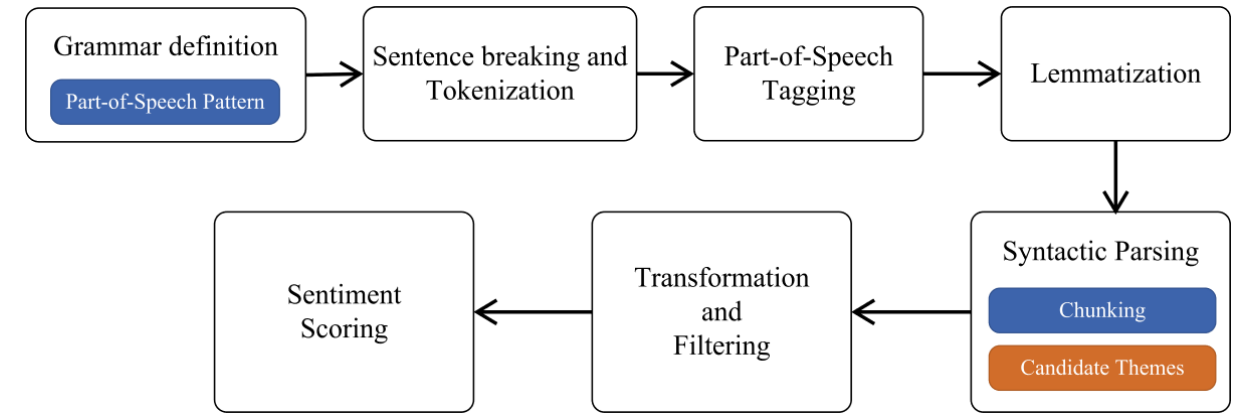
Figure 2. Natural language processing